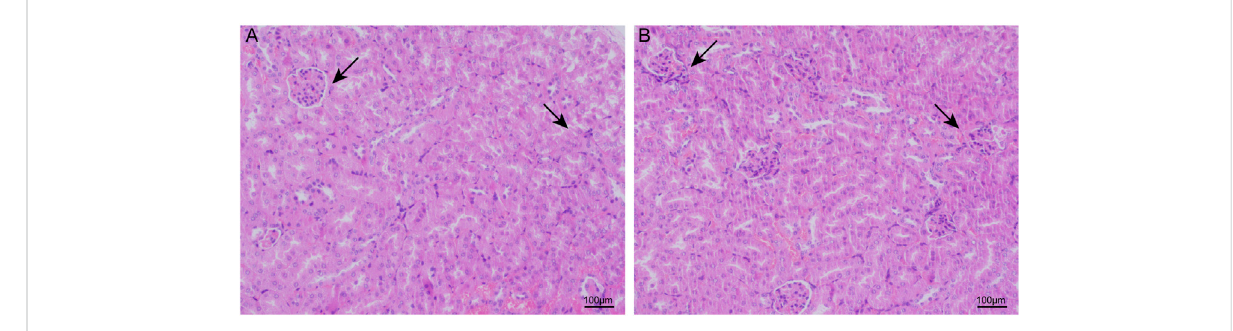
FIGURE 1 CIH caused renal structure damage in mice. In light microscopic examination, glomerular and renal tubular epithelial cell swelling and glomerular atrophy were more remarkable in the renal tissues of the CIH groups (B)